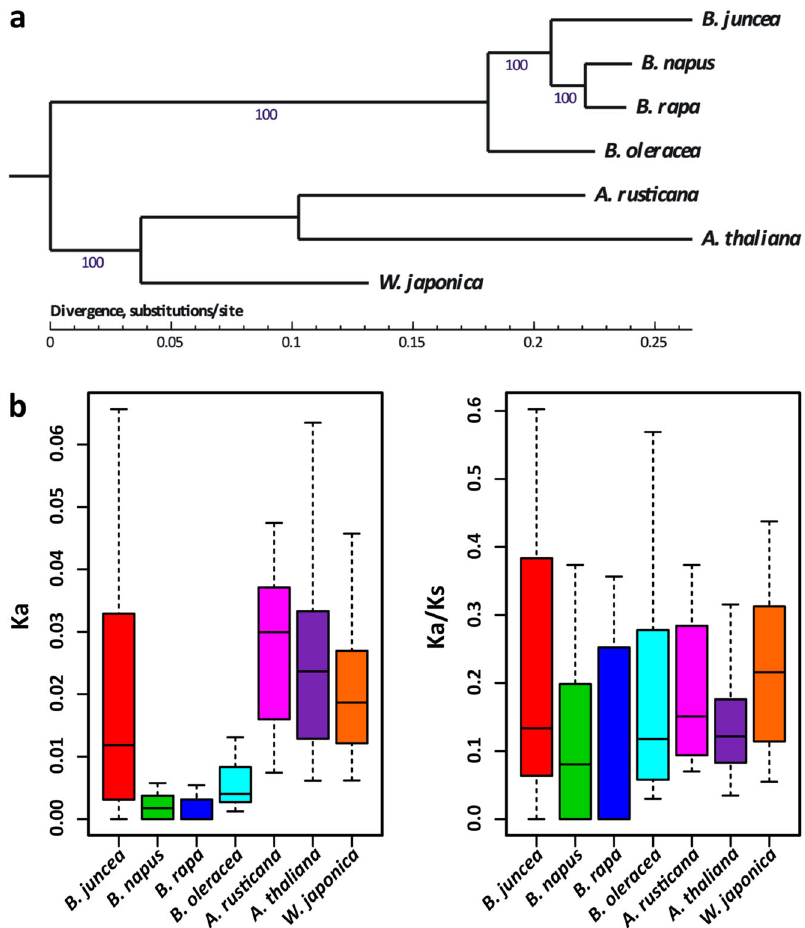
Fig. 3 Phylogenetic evolutionary analysis of genes related to GSL metabolism in Brassicaceae . a Phylogenetic tree of W . japonica , A . rusticana , and B . juncea along with several other Brassicaceae species. b Ks and Ka/Ks values for seven species of Brassicaceae obtained using one-to-one GSL metabolism- related orthologs in Brassicaceae